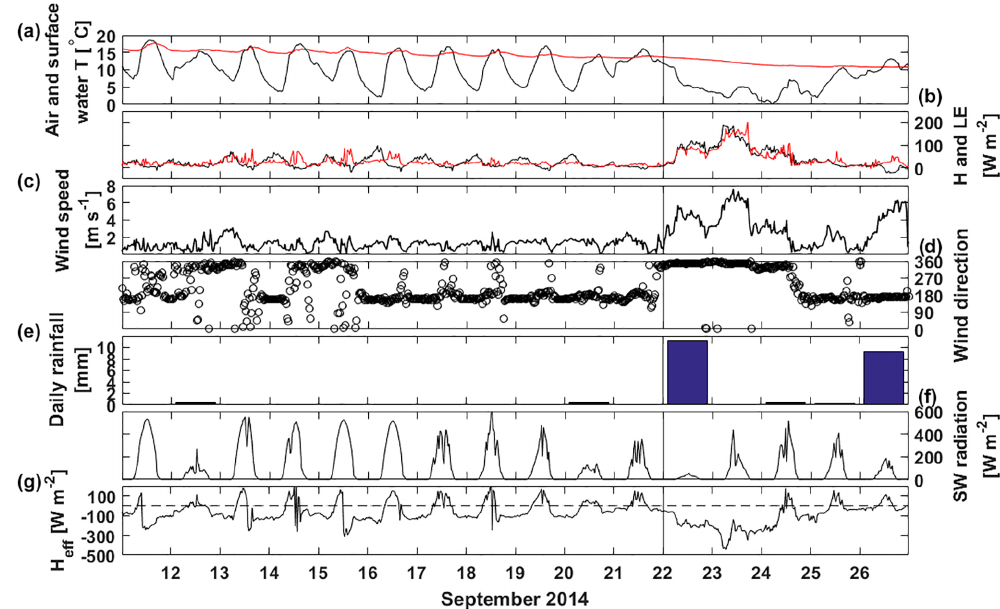
Figure 2. Half-hour averages of (a) measured air temperature (black) and lake surface water temperature (red), (b) sensible (black) and latent (red) heat fluxes measured with the EC system and gap-filled using a bulk formula (see Sect. 2.2.1 and Mammarella et al., 2015, for details), (c) wind speed, (d) wind direction, (e) daily rainfall, (f) incoming shortwave radiation and (g) effective heat flux measured at the measurement raft. Time ticks represent midnight and the vertical black line the start of the lake mixing period.